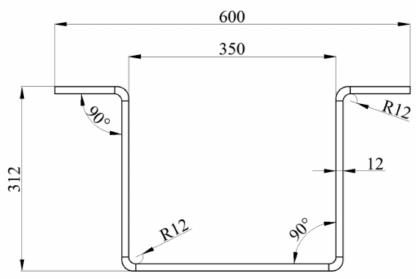
Figure 4. A section diagram of the channel steel with an outer edge.